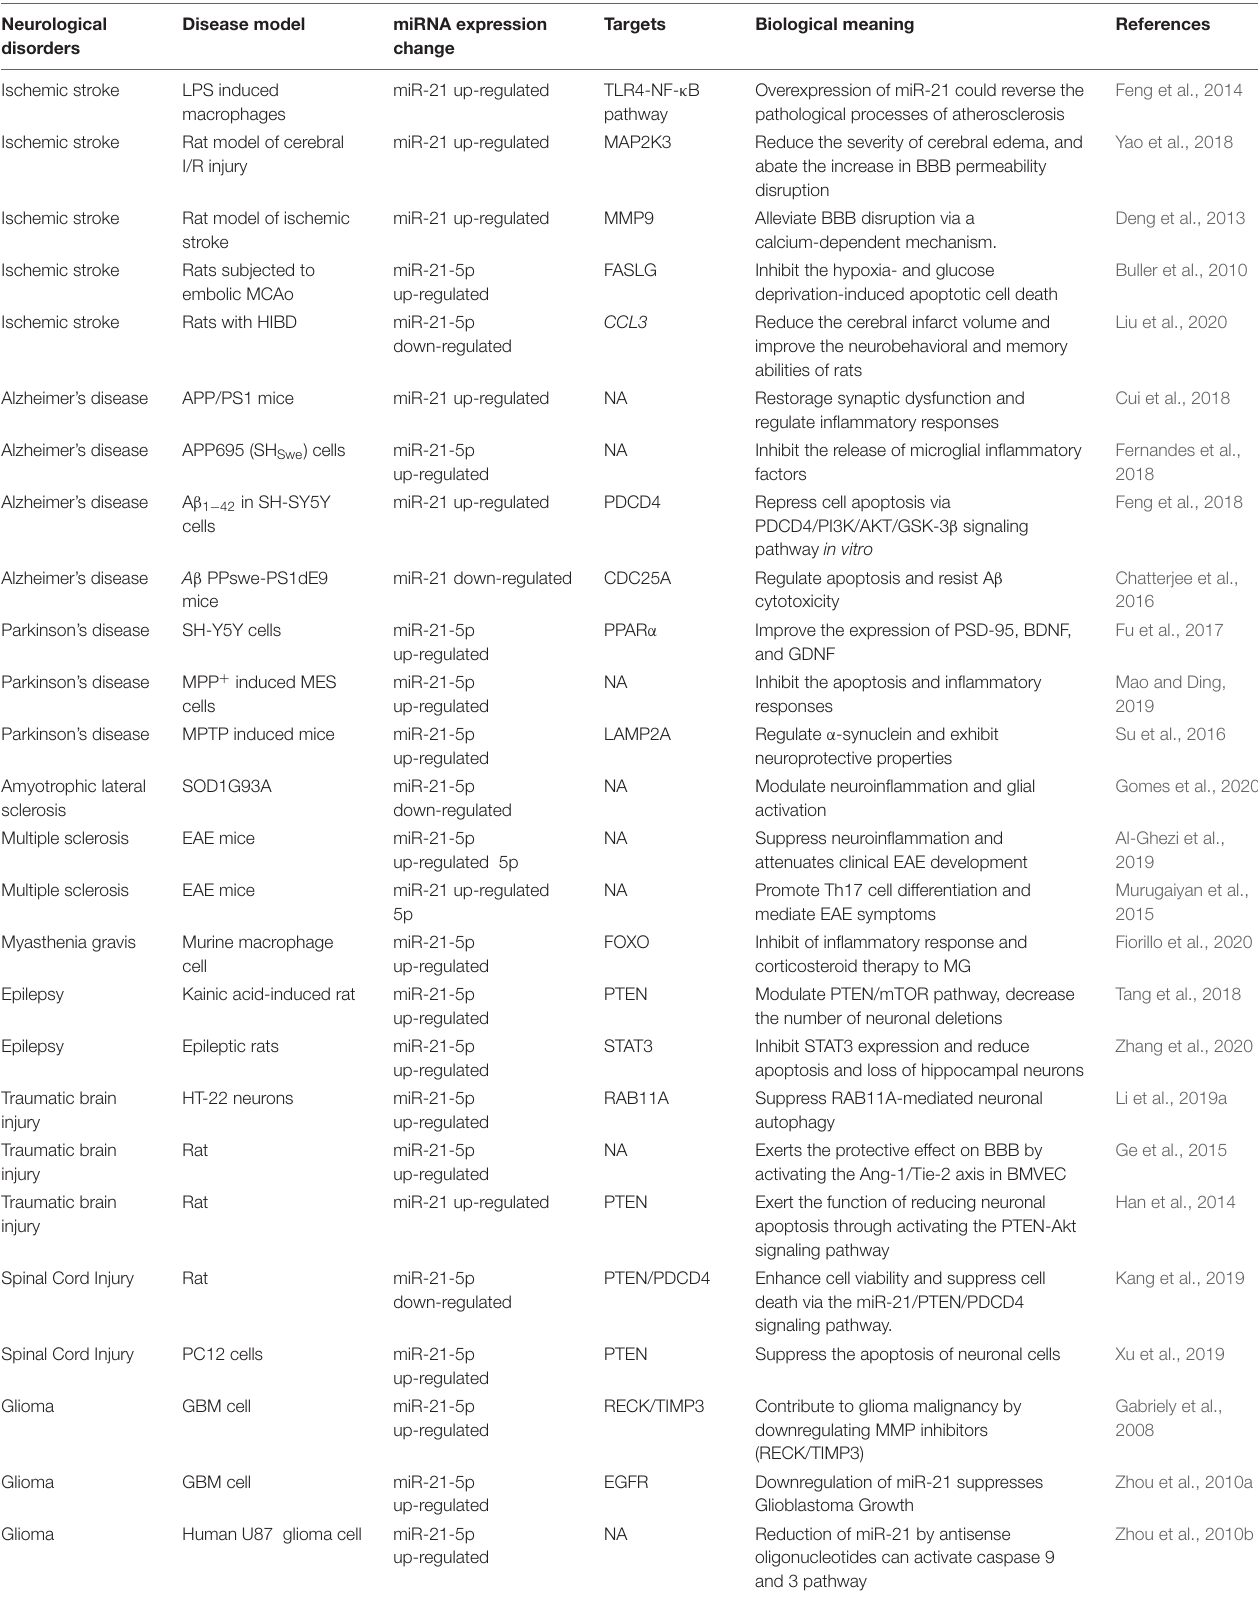
TABLE 1 | miR-21 functions in Neurological